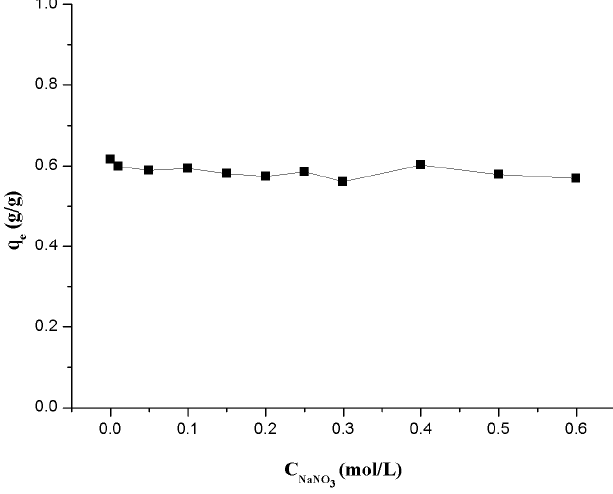
Figure 7. Effect of the ionic strength of the solution on the adsorption of Th(IV) onto β -CD(AN- co -AA). ([Th(VI)]] 0 = 6.5334 × 10 − 4 M, m/V = 0.18 g/L, pH = 2.95 ± 0.05, T = 298.15 ± 1.00